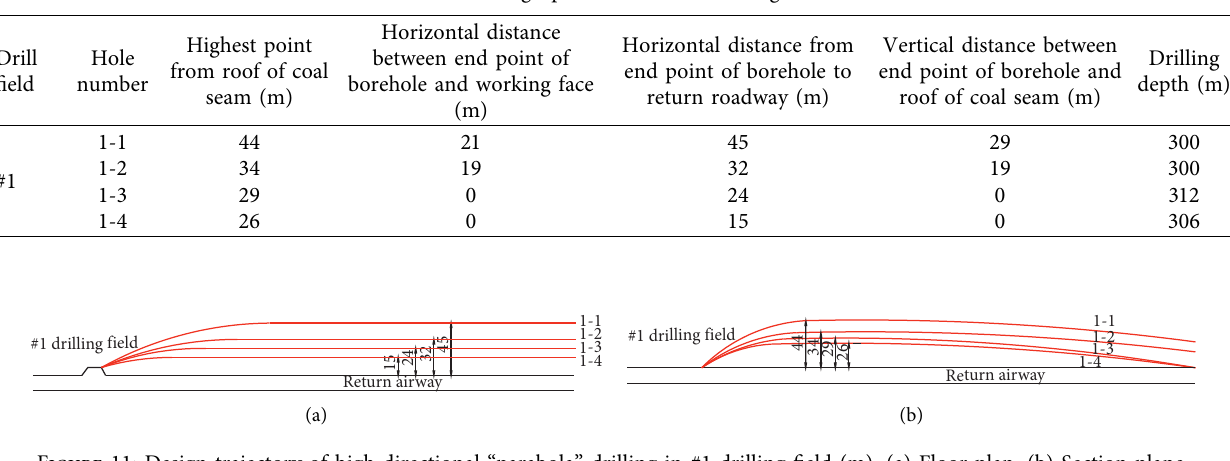
Figure 10: Distribution curve of gas concentration in the fractured Table 4: Design parameters of #1 drilling field.